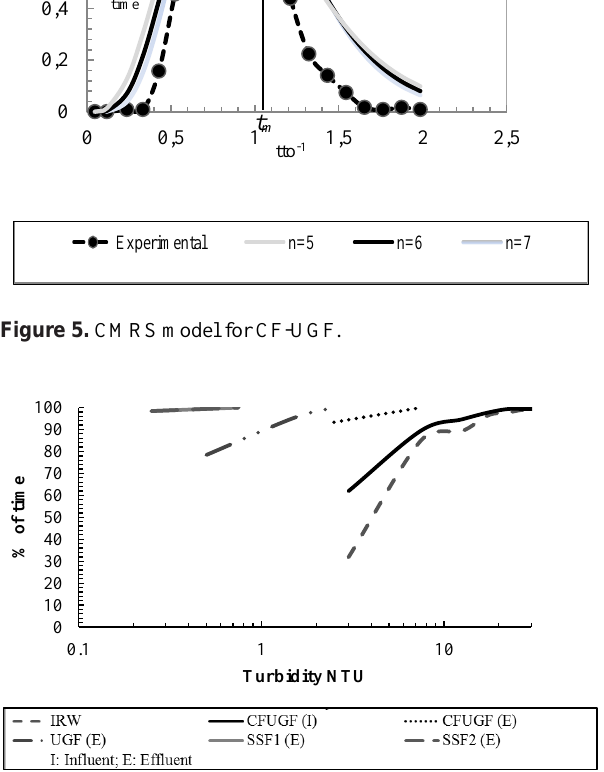
Figure 6. Frequency of turbidity levels (operation without coagu- lant).